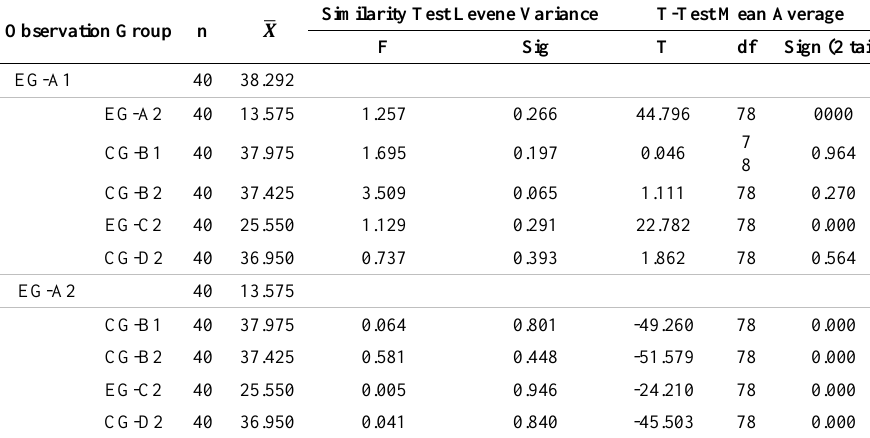
Table 2. Combined Summary of t-Test